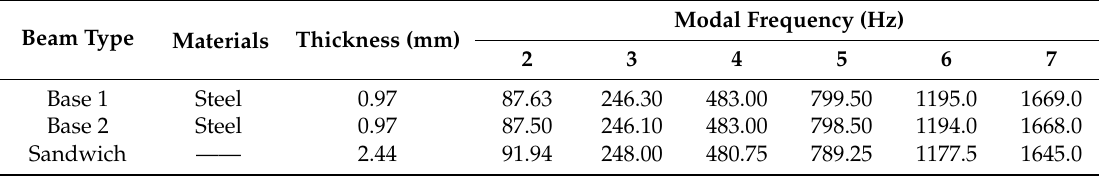
Table 3. Tested modal frequencies of the long symmetrical sandwich beam